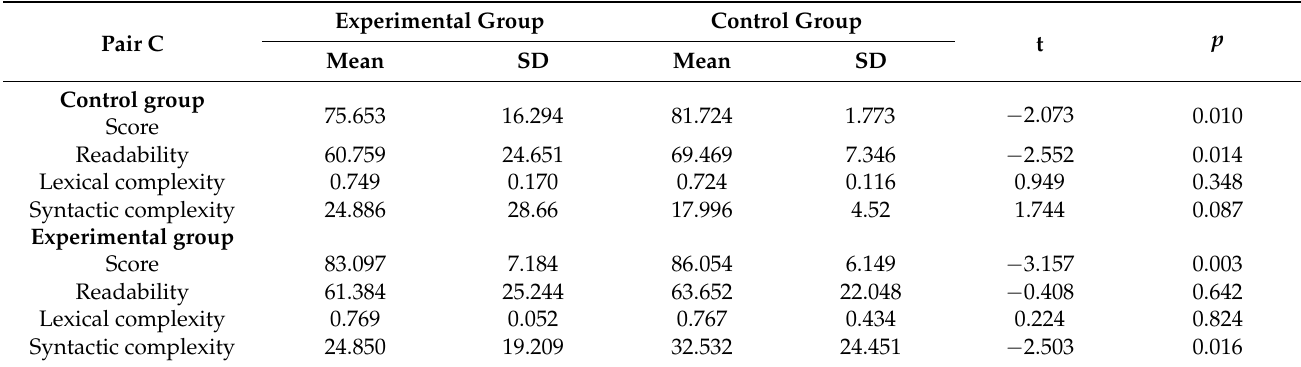
Table 3. Descriptive statistics and t -test results, pretest and